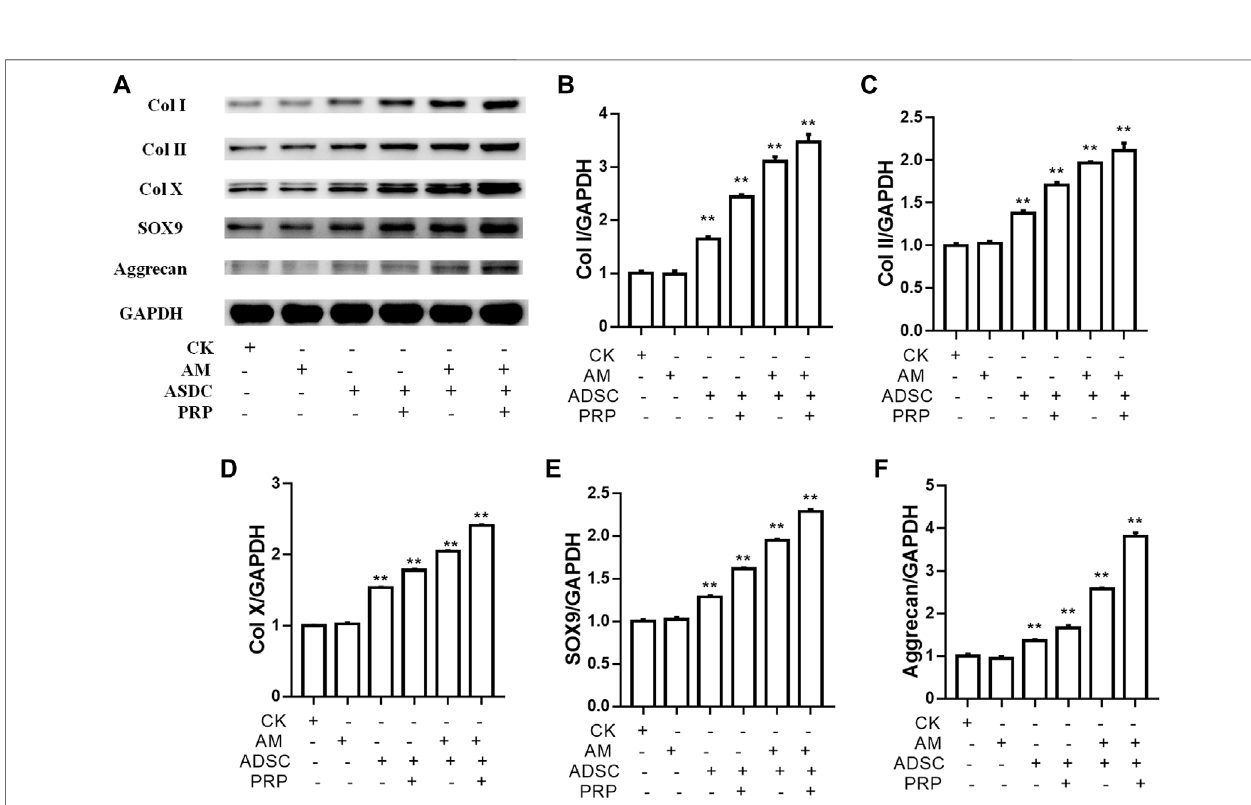
FIGURE8| Amnioticmembrane+PRPgroupshowedthehighesttranslationallevelsofCol I,ColII,ColX,Aggrecan,andSOX9genesintheextracellularmatrixof cartilage. (A) Western blot test was used to detect the expressions of collagen I/II/X, Sox-9, and Aggrecan. The sequence of protein expression levels of these genes fromhightolowisasfollows:ADSC+amnioticmembrane+PRPgroup > ADSC+amnioticmembranegroup > PRP+ADSCgroup > ADSC > amnioticmembraneand control group ( *p < 0.05, **p < 0.01; a p -value of less than 0.05 was considered as statistically signi fi cant). Six groups were included for the analysis, including the controlgroup,ADSCalone,amnioticmembranealone,ADSC+amnioticmembrane,ADSC+PRP,and ADSC+amnioticmembrane +PRP.Fiverabbits wereincluded for every group and the extracellular matrix of cartilage was isolated for protein extraction. Ten micrograms of protein was loaded and GAPDH was considered as the loadingcontrol, (B – F) Thequanti fi cationof (B) collagenI, (C) collagenII, (D) collagenX, (E) Sox9,and (F) aggrecanforthebandsin (A) ( *p < 0.05, **p < 0.01;a p -valueof less than 0.05 was considered as statistically signi fi